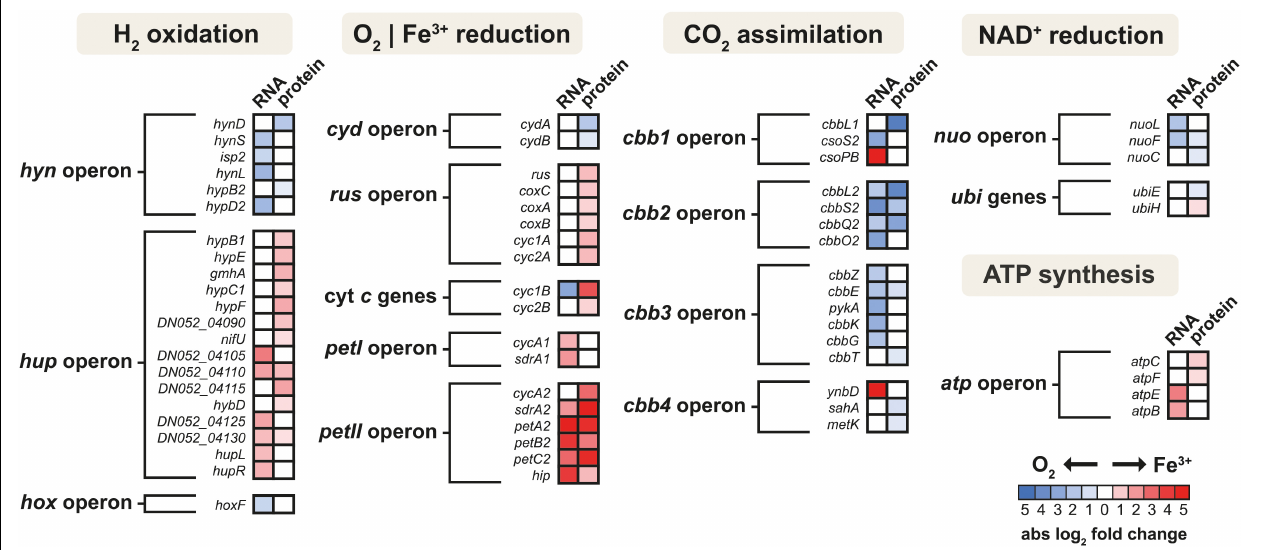
FIGURE 2 | The heat map of products of energy metabolism-related gene clusters that were differentially expressed in aerobically and anaerobically grown At. ferrooxidans cells with hydrogen as an electron donor. Shown are only genes and proteins that changed significantly ( q < 0.05) with absolute log 2 fold change > 1 for gene transcripts and 0.58 for